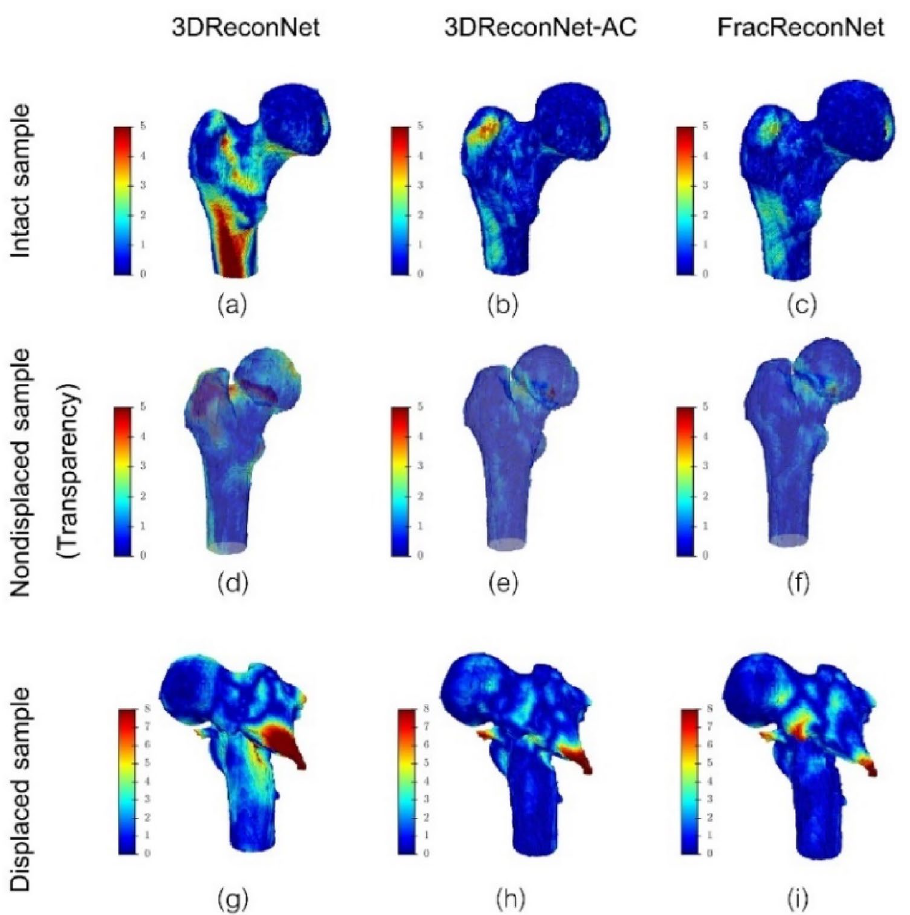
Figure 6. Surface distance error of the reconstructed 3D femur shape using 3DReconNet, 3DReconNet-AC and FracReconNet. The surface distance is based on the ground truth shape for ( a–c ) intact, ( d–f ) nondisplaced, and ( g–i ) displaced samples.